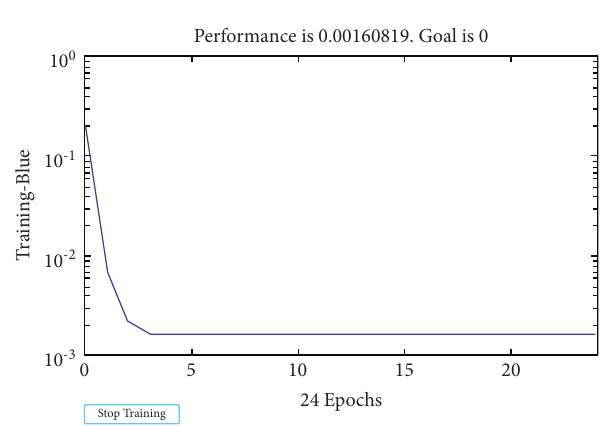
Figure 8: Performance curve for abrasion loss